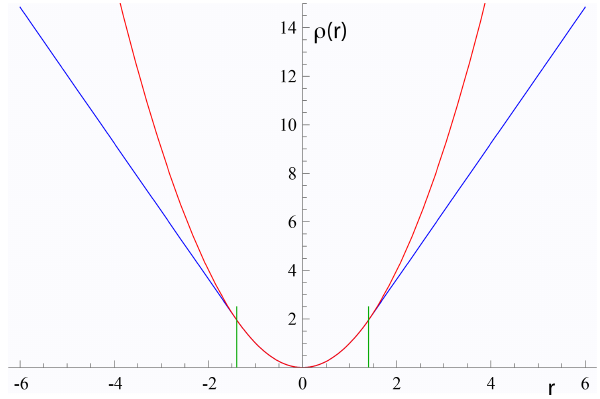
Figure 3. Plots of ρ ( r ) against r for YORK in red ( r 2 ) and for Huber in SPINE (Eq. 3) in blue. The two curves are coincident for | r | < h , with h = 1 . 4 the vertical green lines. See